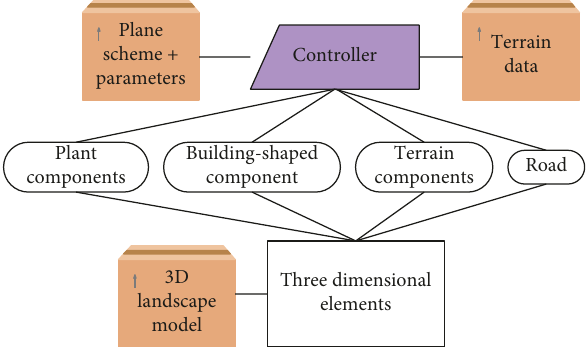
Figure 5: Overview of the parameter structure